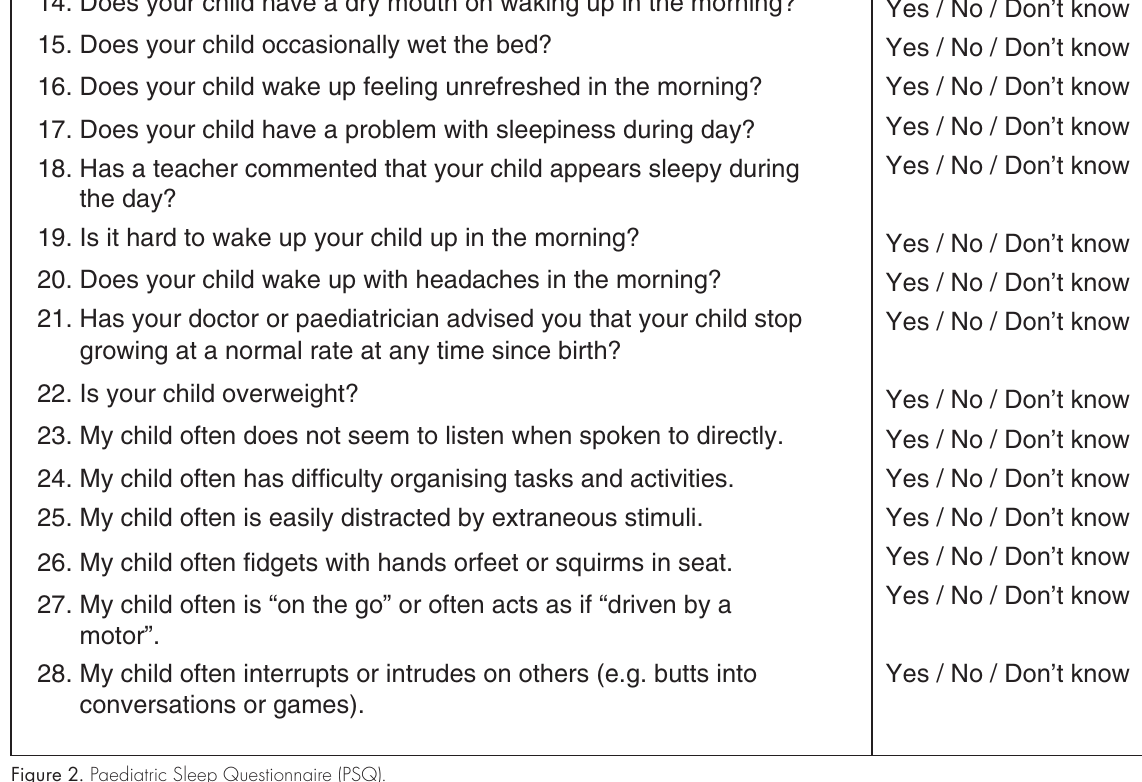
Figure 2. Paediatric Sleep Questionnaire